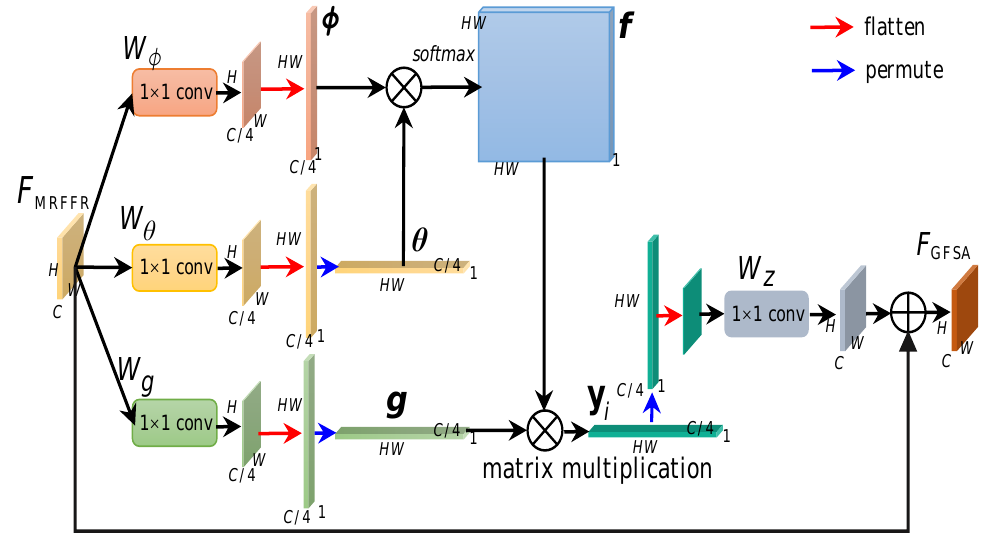
Figure 8. Implementation of the global feature self-attention (GFSA) in GCIM-Block.